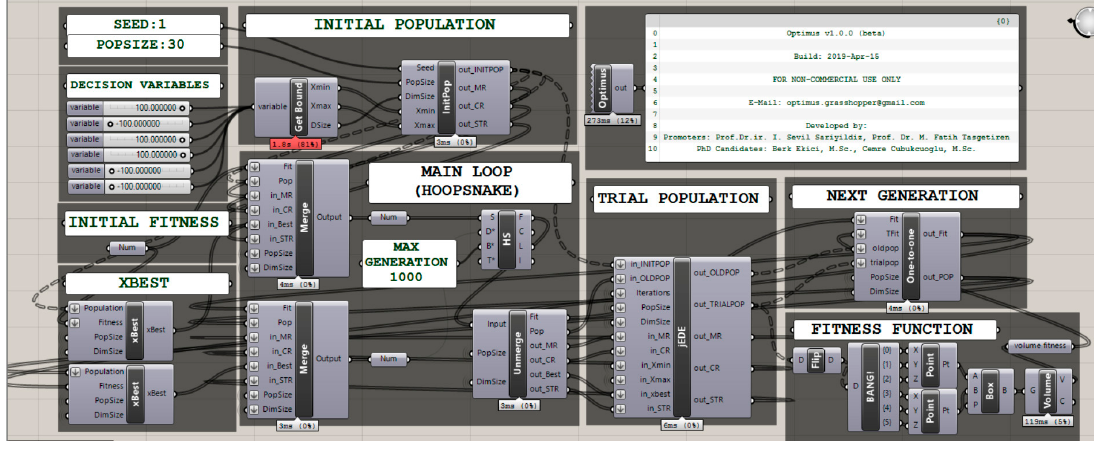
Figure 6. Visualization of the Optimus loop.